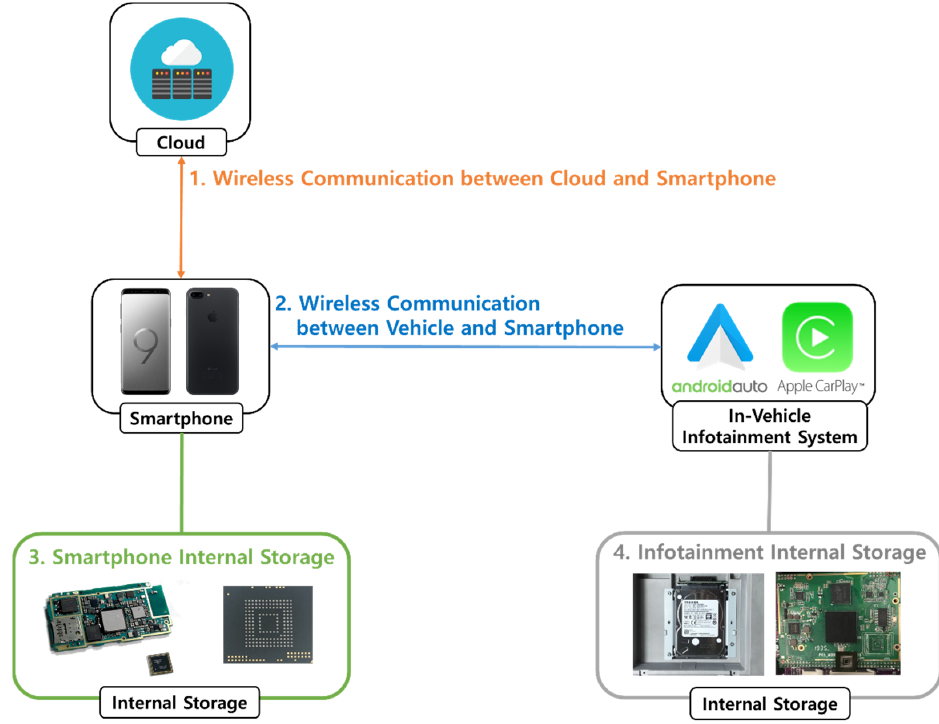
Figure 1. Forensic methodology for analysis of IVI system.